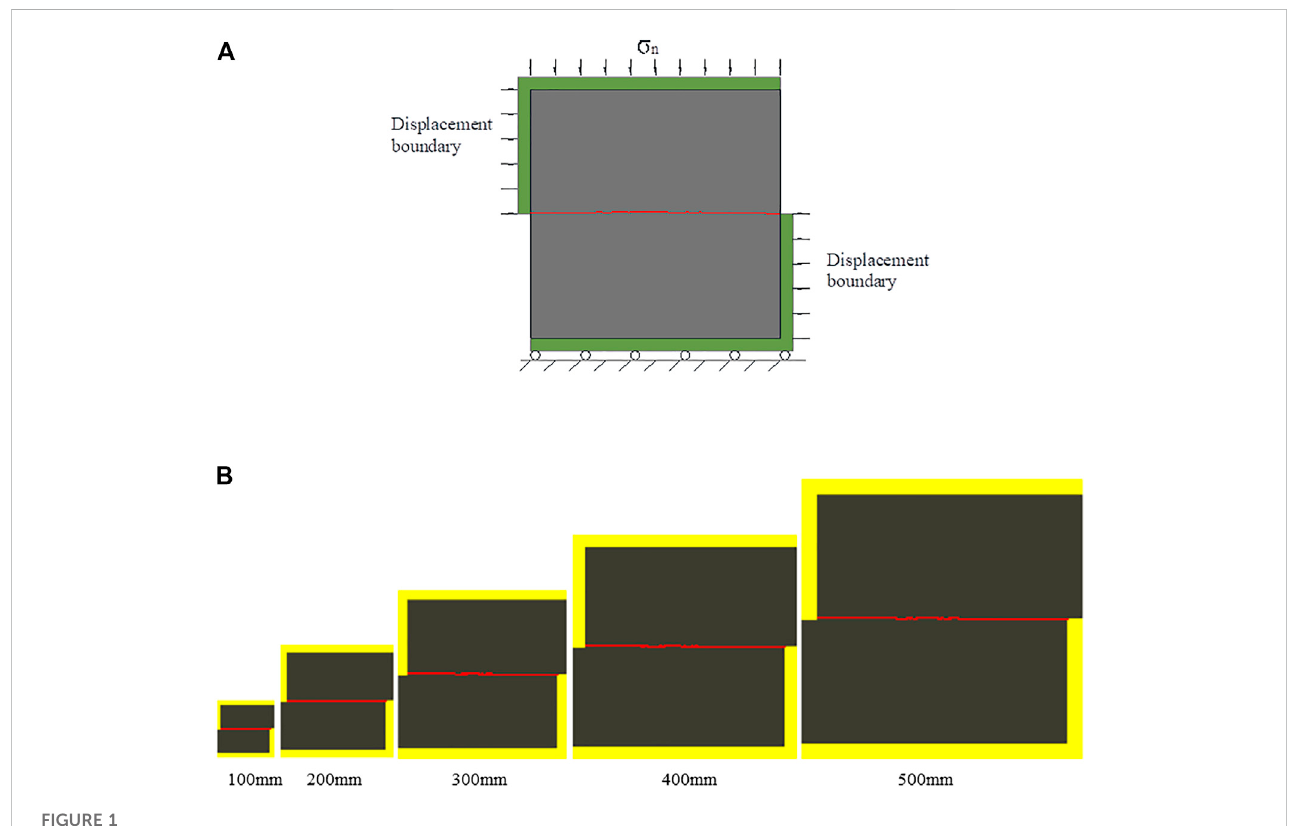
FIGURE 1 Rock models. (A) Mechanical model. (B) Size model.